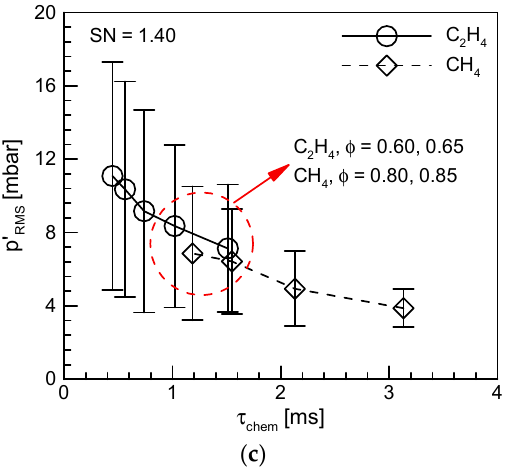
Figure 8. Effect of characteristic chemistry times on RMS values of half-wave pressure oscillation: ( a ) SN = 0.46, ( b ) SN = 0.80, and ( c ) SN = 1.40.